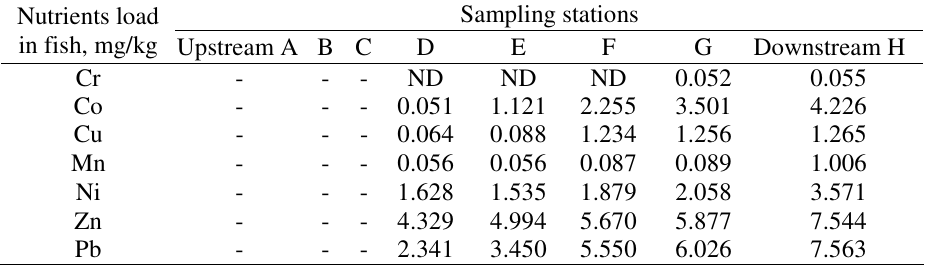
Table 4. Heavy metal concentration in fish muscles (mg/kg) in various sampling stations.